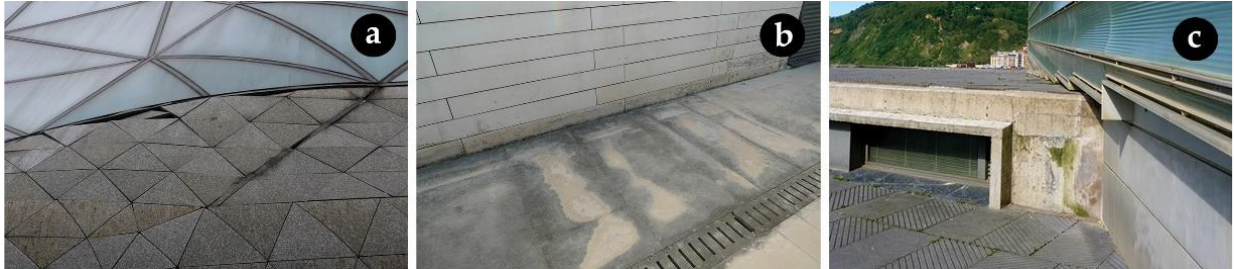
Figure 13. Iconic projects with premature patterns of defects. ( a ) Guangzhou Opera House (2002–2010) (ph. Cardellicchio, 2017); ( b ) rectory of the of Nova Universidade in Lisbon (1997–1999) (ph. Tombesi, 2014); ( c ) concert and convention centre Kursaal in San Sebastian (1996–1999) (ph. Tombesi, 2013).